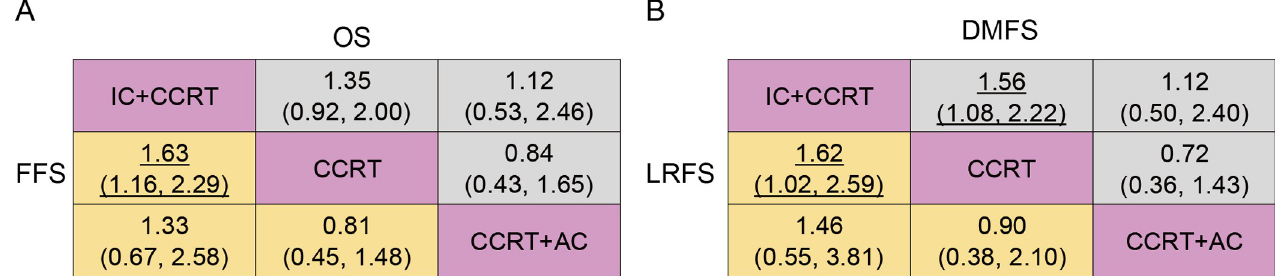
Fig 2. Bayesian network analysis results for 5-year overall survival (A up), failure-free survival (A below), distant metastasis-free survival (B up), and locoregional recurrence-free survival (B below). Treatments in the rows were compared with those in the columns. Highlighting numbers, odds ratios (ORs) with significant differences. IC+CCRT, induction chemotherapy followed by concurrent chemoradiotherapy; CCRT+AC, concurrent chemoradiotherapy followed by adjuvant chemotherapy; CCRT, concurrent